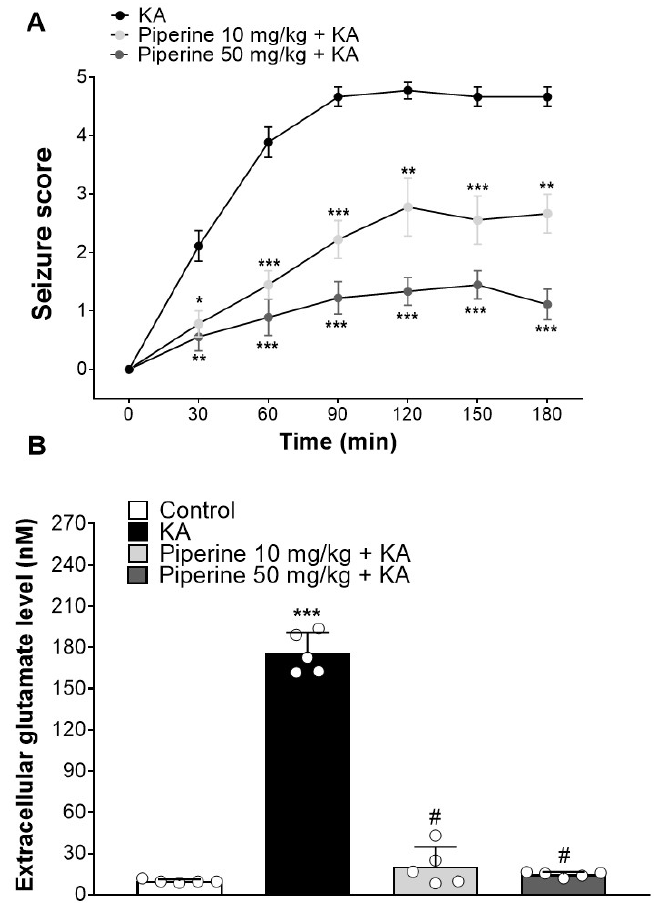
Figure 3. Effect of piperine pretreatment on seizure severity and extracellular glutamate levels in rats with KA. ( A ) Seizure scores are recorded every 30 min (n = 9). * p < 0.05; ** p < 0.01; *** p < 0.001 versus the KA group. ( B ) The extracellular glutamate levels from the cisterna magna were evaluated by HPLC (n = 5). Data are presented as the means ± S.E.M. # p < 0.001 versus the KA group; *** p < 0.001 versus the control group (ANOVA/Scheffé).